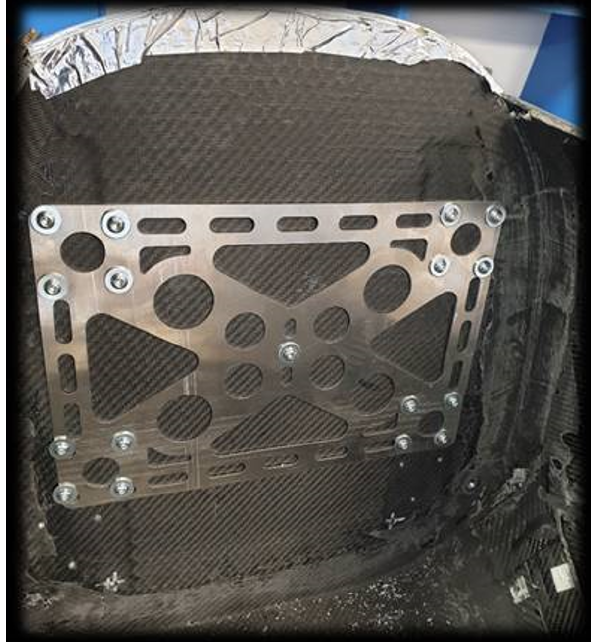
Figure 13: Center plate